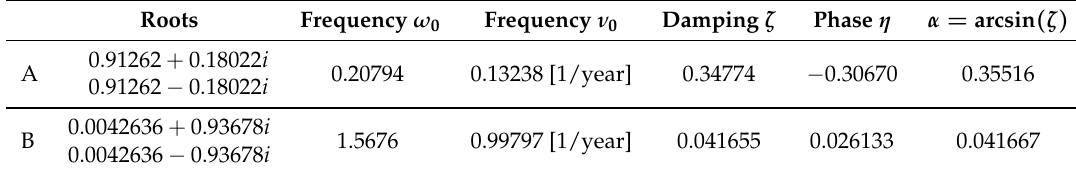
Table 3. Approximation with SOGM-components, i.e., ARMA(2, q )-models. The variance of the combined covariance function amounts to σ 2 = 0.02235mm 2